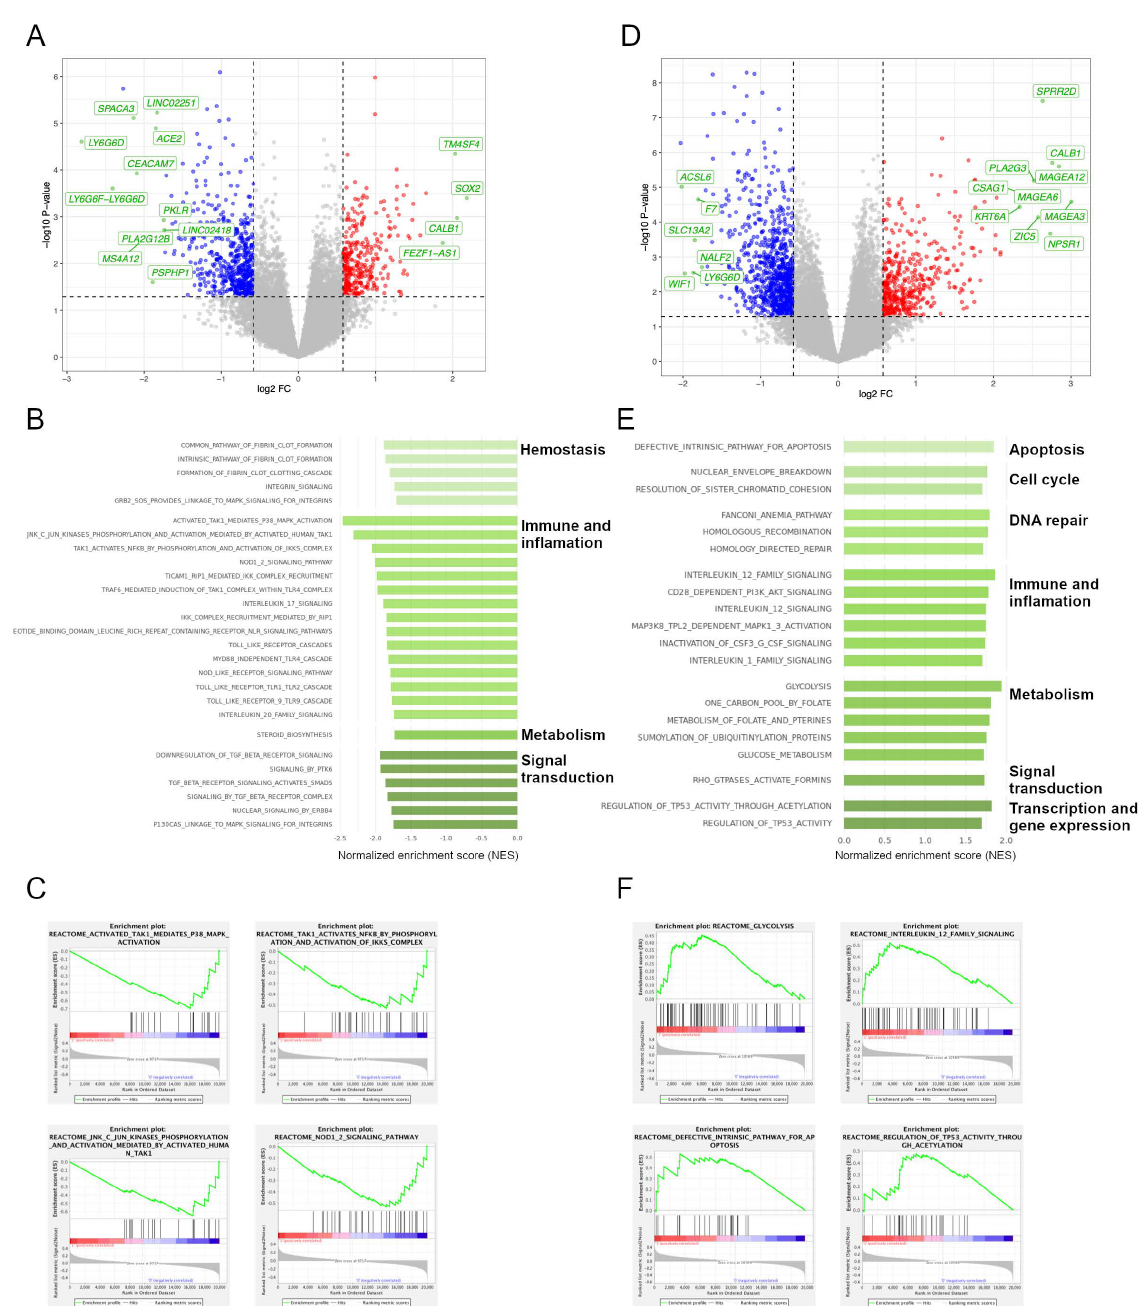
Figure 3. Deregulated cancer–related transcriptomic pathways underlying SMAD4 and FBXW7 mutations in TP53 –defficient tumors. ( A , B ) Volcano plots displaying differentially expressed genes in tumors harboring a mutated genotype for ( A ) TP53/SMAD4 and for ( B ) TP53/FBXW7 . Grey circles indicate genes with non–significant expression differences, red circles indicate significantly overexpressed genes (with log2 FC > 0.58 and non–adjusted p < 0.05), and blue circles label signif- icantly under–expressed genes (with log2 FC < − 0.58 and non–adjusted p < 0.05). Genes that are highlighted in green show the highest FC in gene expression (for TP53/SMAD4 : log2 FC > 1.5 or log2 FC < − 1.5; for TP53/FBXW7 : log2 FC > 2 or log2 FC < − 2). ( C , D ) Most significantly enriched gene sets and categories from REACTOME and KEGG in double–mutated ( C ) TP53/SMAD4 and ( D ) TP53/FBXW7 tumors, according to a NES > |1.75| and nominal p < 0.05. ( E , F ) Exemplary GSEA plots of those significant gene sets with the highest enrichment scores in ( E ) TP53/SMAD4 –mutated and ( F ) TP53/FBXW7 –mutated